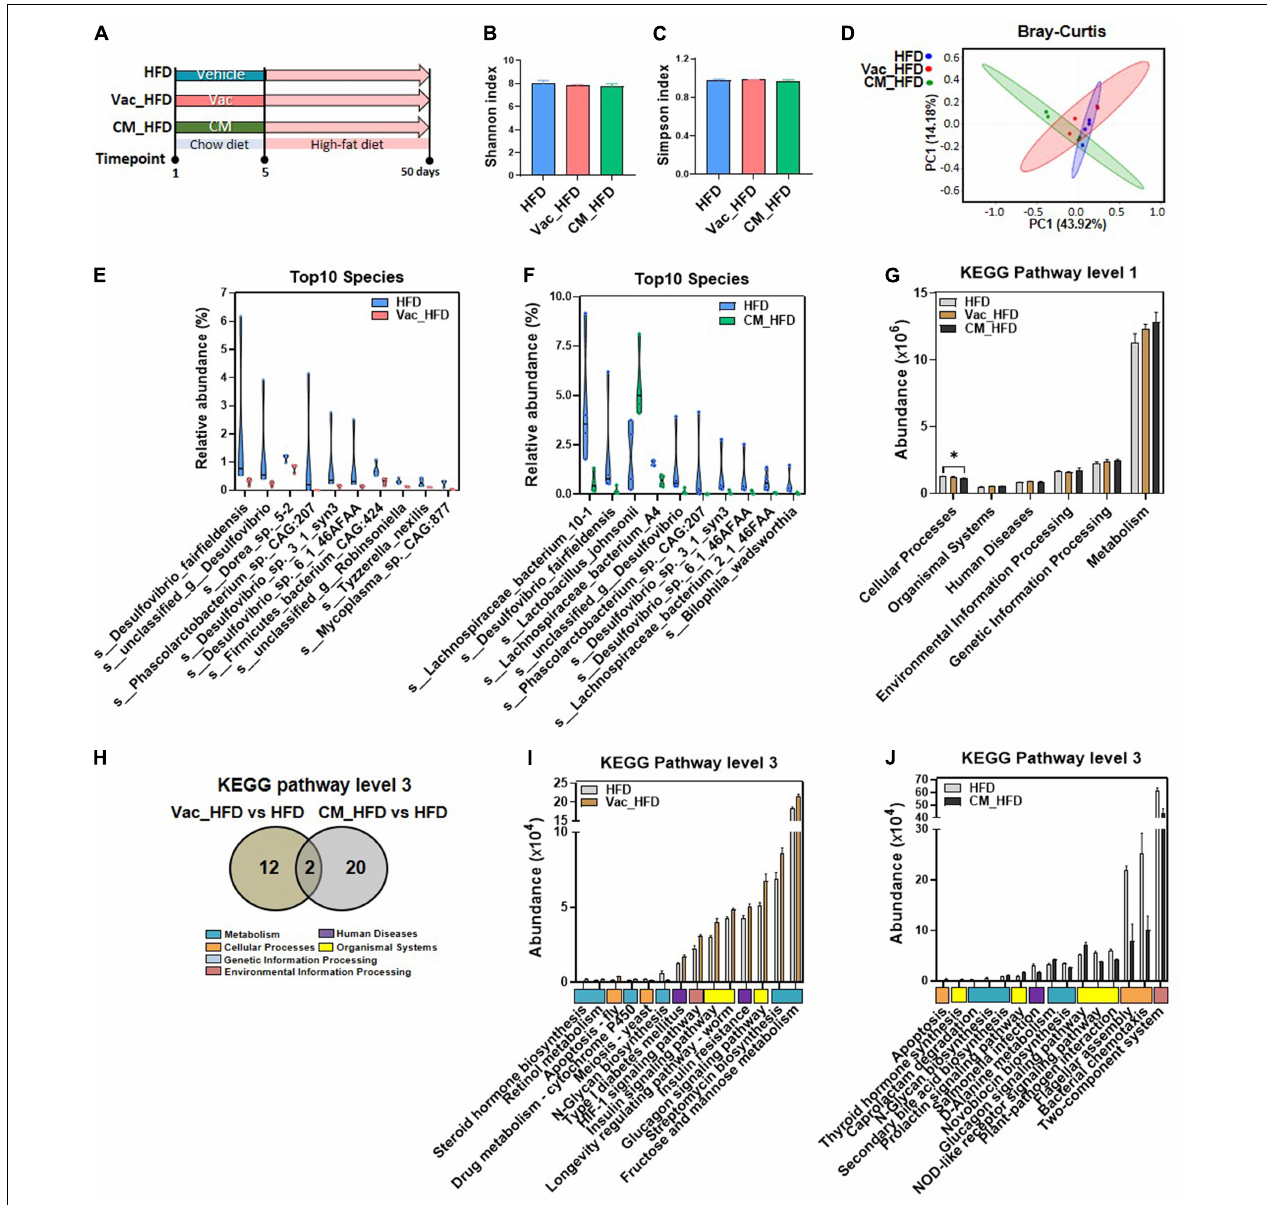
FIGURE 5 | HFD affects post-antibiotic recovery of gut microbiota composition and function. (A) Intervention process chart. Rats were treated with vehicle, Vac, or CM for 5 days and then fed with a high-fat diet for another 45 days. (B) Shannon index. (C) Simpson index. (D) Principal co-ordinate analysis based on the Bray–Curtis distance algorithm at species level. (E,F) Top 10 differential species between Vac_HFD and HFD and between CM_HFD and HFD ( p < 0.05 by the Mann–Whitney U test). (G) The function differences among groups on KEGG pathway level 1 predicted by PICRUSt2. * p < 0.05 by Student’s t -test. (H) Venn diagram of the overlap of differential enriched pathways between Vac_HFD vs. HFD and CM_HFD vs. HFD by PICRUSt2 analysis on KEGG pathway level 3 ( p < 0.05 under the Mann–Whitney U test). (I) The shifted pathways between Vac_HFD and HFD. (J) Top 15 shifted pathways between CM_HFD and